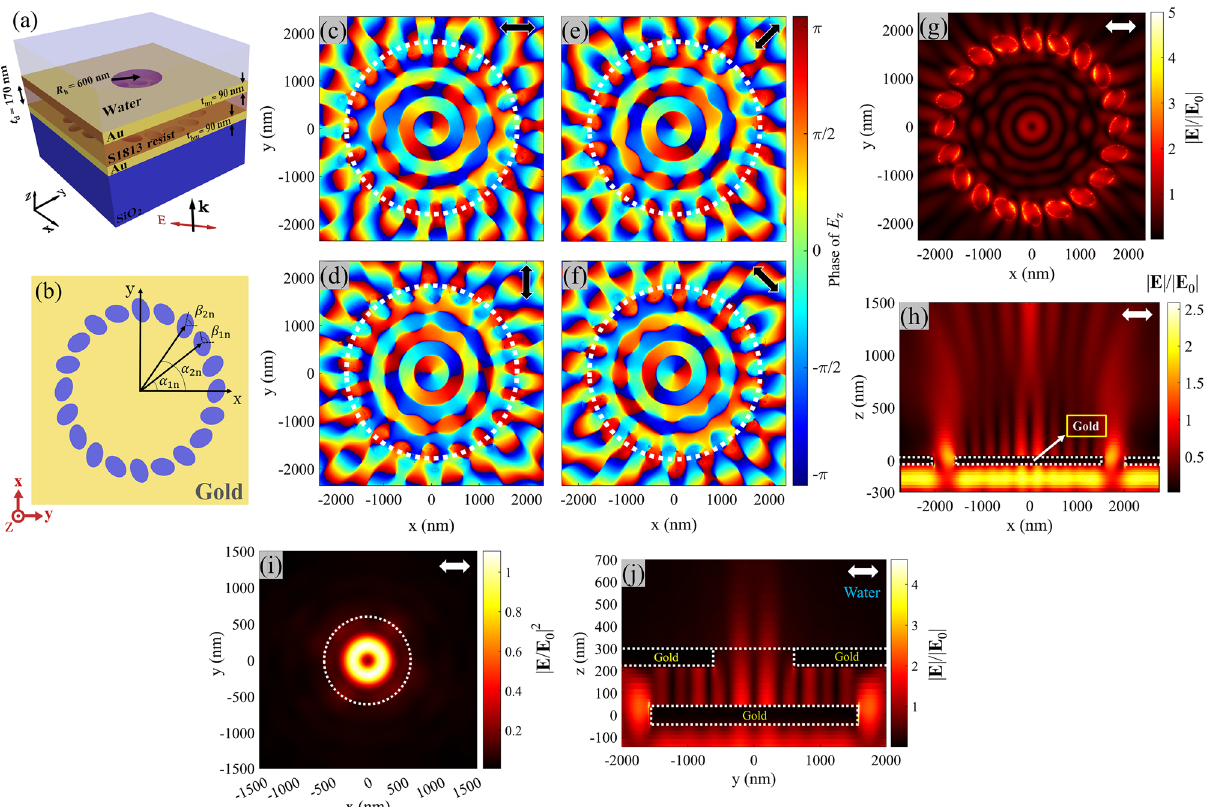
Figure 7. ( a ) Three-dimensional schematic of MIM structure and ( b ) The schematic diagram of the polarization independent array of elliptical holes embedded in the bottom gold layer. ( c – f ) Phase distribution of E z for θ = 0°, 90°, 45° and − 45°, respectively. Dashed lines indicate the location of holes position ( g , h ) Normalized electric field distribution in x – y plane and x – z plane, respectively for θ = 0°. ( i ) Normalized electric field intensity distribution at x – y plane and ( j ) Normalized electric field amplitude distribution in y – z plane, in MIM configuration for θ = 0°. White dashed lines illustrate the gold layer boundaries. White and black arrows indicate orientation of linear